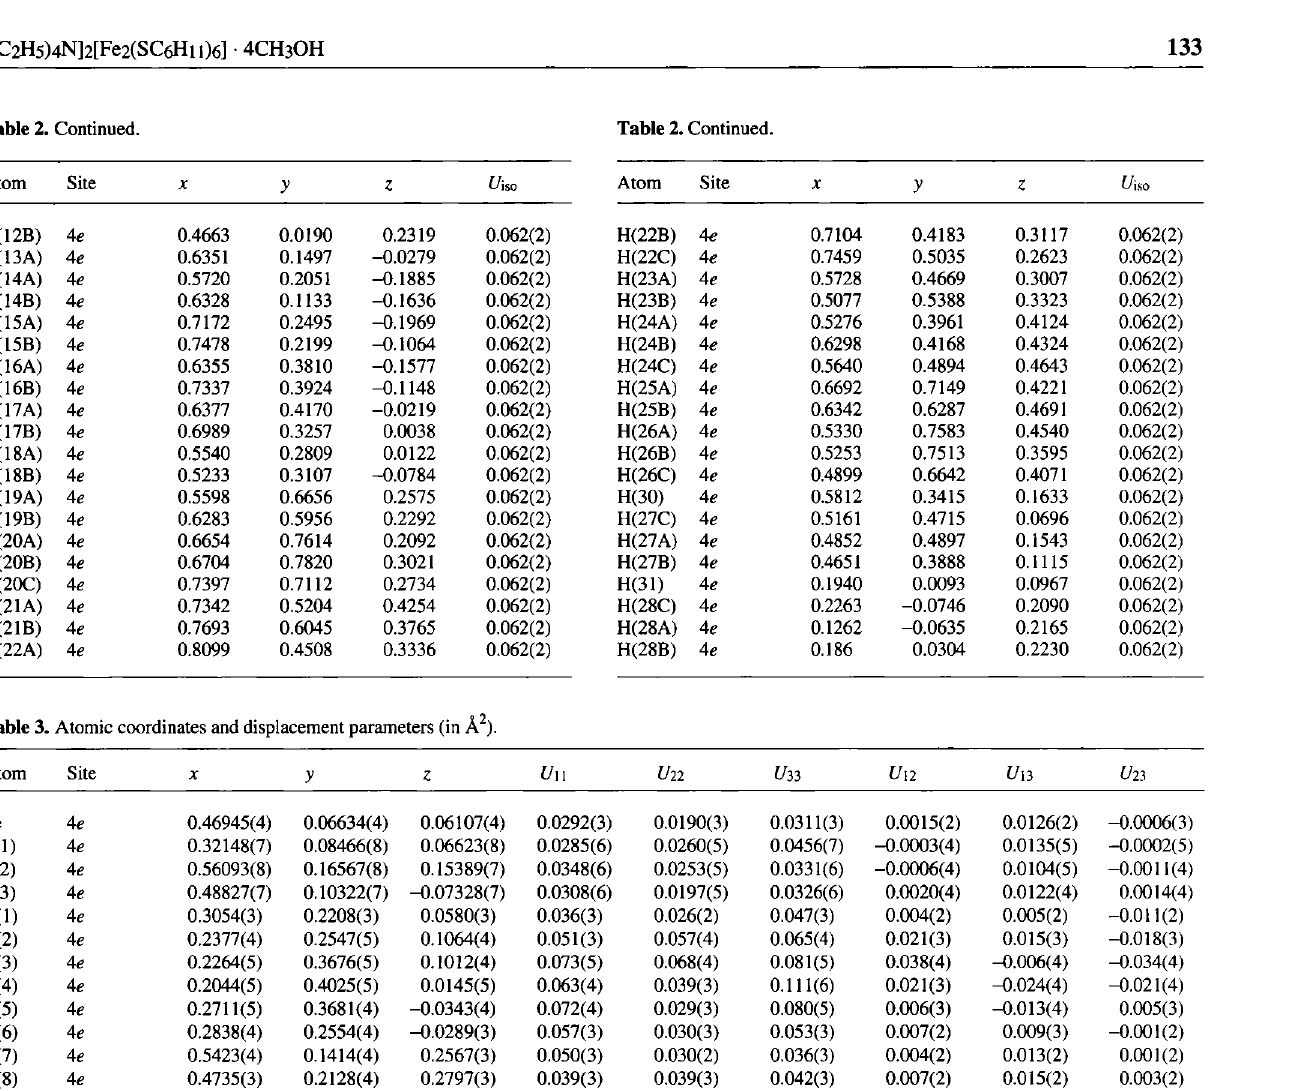
Table 3. Atomic coordinates and displacement parameters (in Â 2